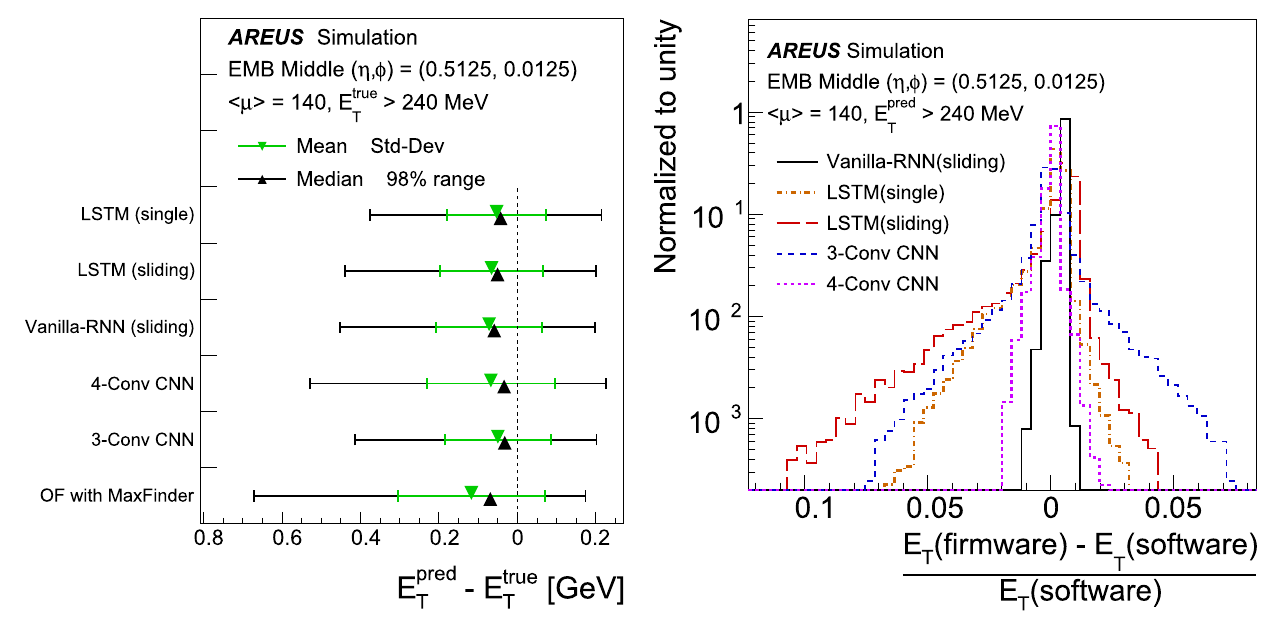
Figure 9. Performance of ML signal processing methods implemented in FPGAs on the LASP, Fig. 6 Transverse energy reconstruction performance for the opti- Fig. 11 Relative deviation of the firmware implementations from specifically the true vs. reconstruction transverse energy for all ML and the legacy methods ( left ), and the software results for the di ff erent transverse energy reconstruction mal filtering and the various ANN algorithms. The performance is the relative energy deviation of firmware ML implementations from the software results ( right ) ANNs. Only bunch crossings with predictions di ff erent from zero and assessed by comparing the true transverse energy deposited in an = 0.5125 = 0.0125 true transverse energies larger than 240 MeV are considered. Inputs EMB middle LAr cell ( 𝜂 and 𝜙 ) to the ANN pre- to the ANNs are sampled pulses obtained from the simulation of an diction after simulating the sampled pulse with AREUS assuming = 0.5125 = 0.0125 = 140 3 𝜎 EMB middle LAr cell ( 𝜂 and 𝜙 ) with AREUS . Only energies above the noise threshold are consid- = 140 assuming ⟨ 𝜇 ⟩ ered. The mean, the median, the standard deviation, and the smallest range that contains 98% of the events are shown